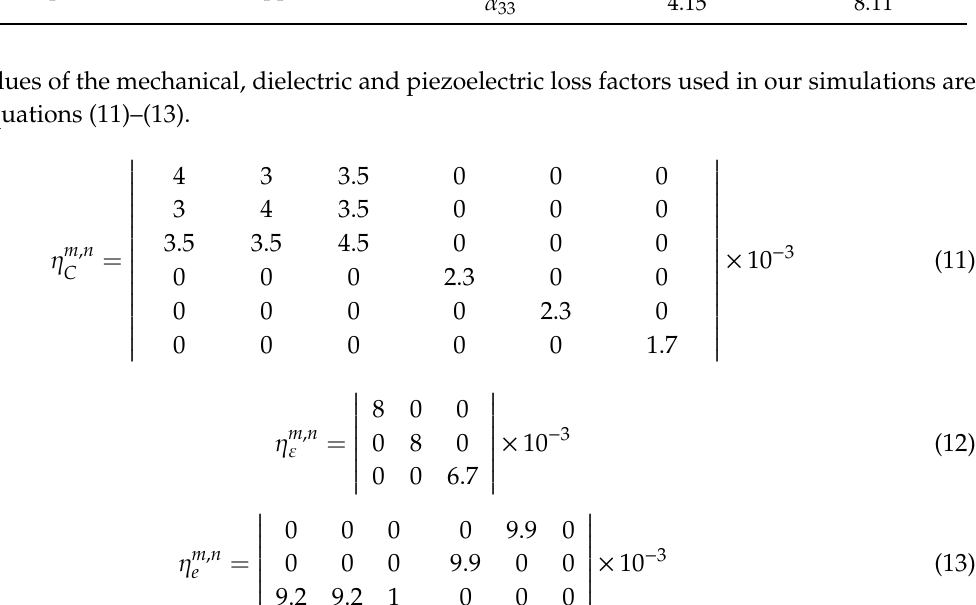
Table 3. First order temperature coe ffi cient values of physical constants of AlN and Sapphire. Material Symbol AlN [36] Sapphire [37] Density temperature coe ffi cient (10 − 6 / ◦ C) Temperature coe ffi cient of elastic constants (10 − 4 / ◦ C) Temperature coe ffi cient of piezoelectric constants (10 − 4 / ◦ C) Temperature coe ffi cient of dielectric constants (10 − 4 / ◦ C) Thermal expansion Coe ffi cients (ppm / ◦